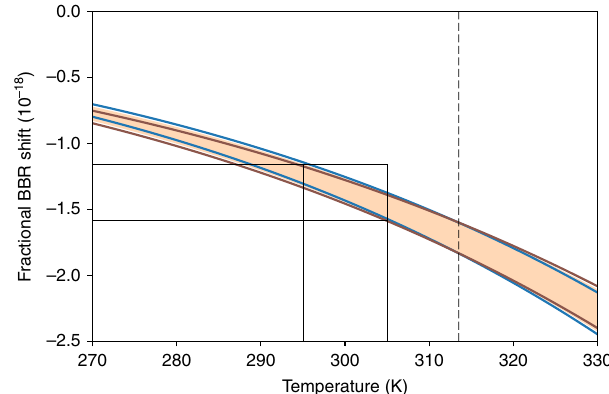
Fig. 4 BBR shift on the 1 S 0 ↔ 3 D 1 transition. The shaded region is the total uncertainty from both the measurement, Δ α 0,1 ( ν m ), and extrapolation, Δ α 0,1 (0). The blue and red lines give the total uncertainty boundaries when Δ α fi xed at 0.012 (a.u.) and 0.024 (a.u.), respectively. Dashed line 0,1 (0) is indicates the temperature at which δν bbr depends only on Δ α 0,1 ( ν m ). Solid lines indicate the operating condition of 300 ± 5 K and corresponding fractional frequency uncertainty of 2 × 10 −